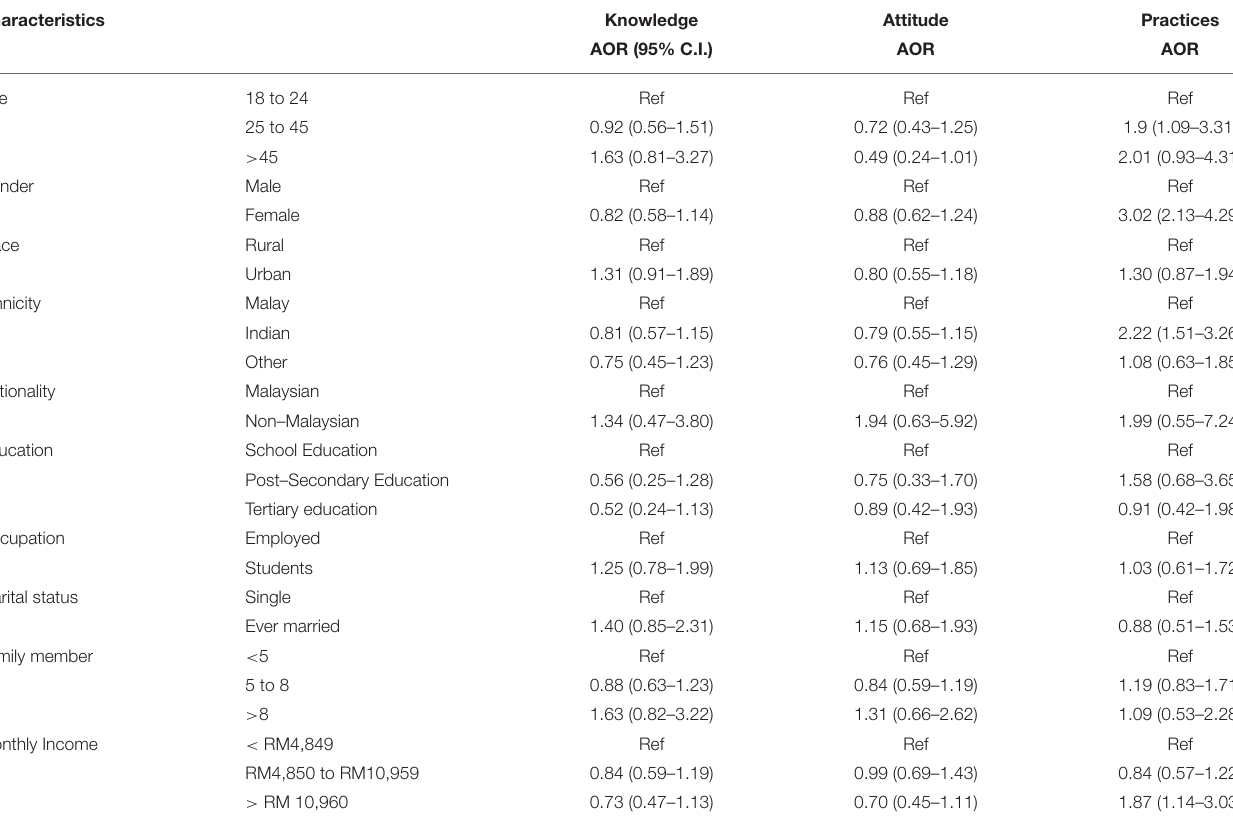
TABLE 2 | Risk factors associated with Knowledge, attitude and practice for COVID-19 among general population.